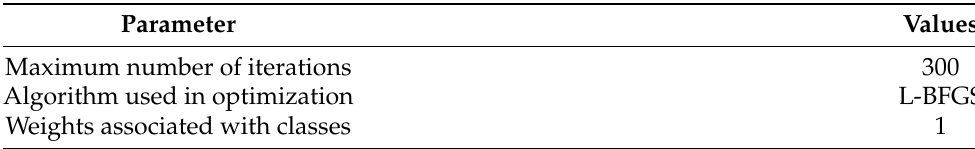
Table A7. Parameters of the logistic